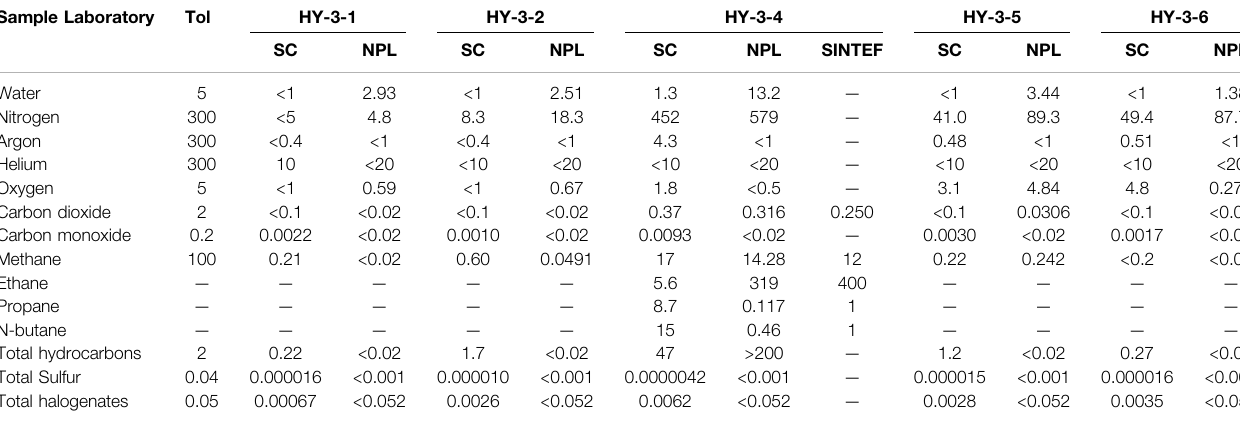
TABLE 6 | Comparison of analytical results from the third sampling campaign. Sample